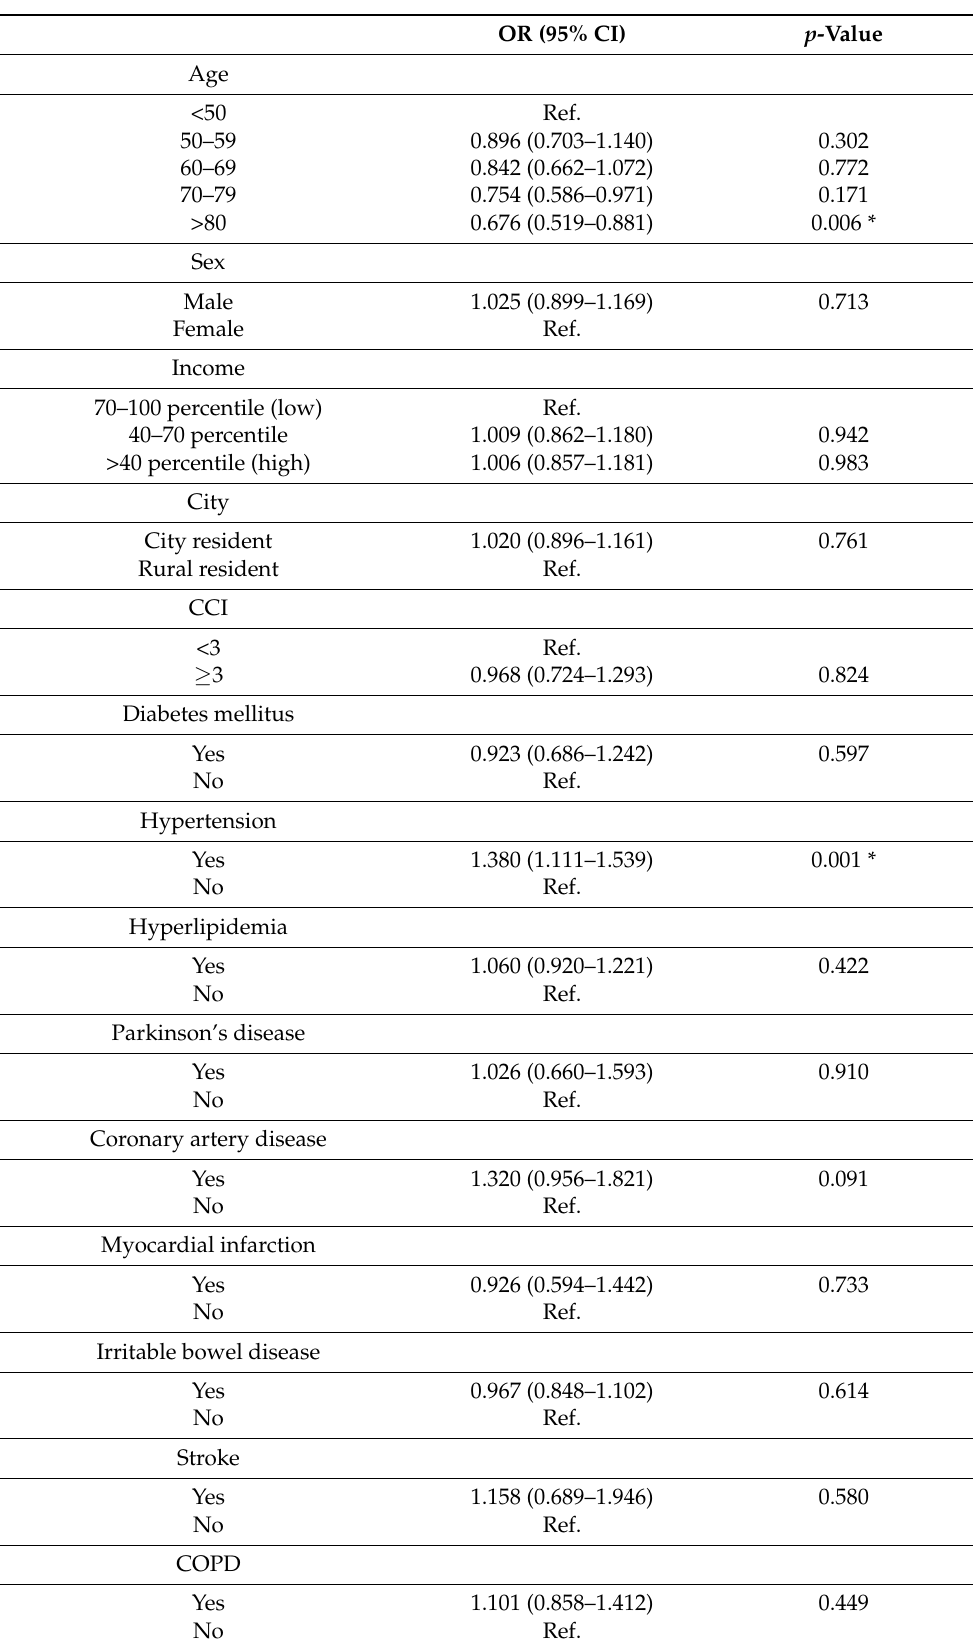
Table 3. Multivariable logistic regression analysis evaluating the association between various sys- temic and ocular comorbidities and skin